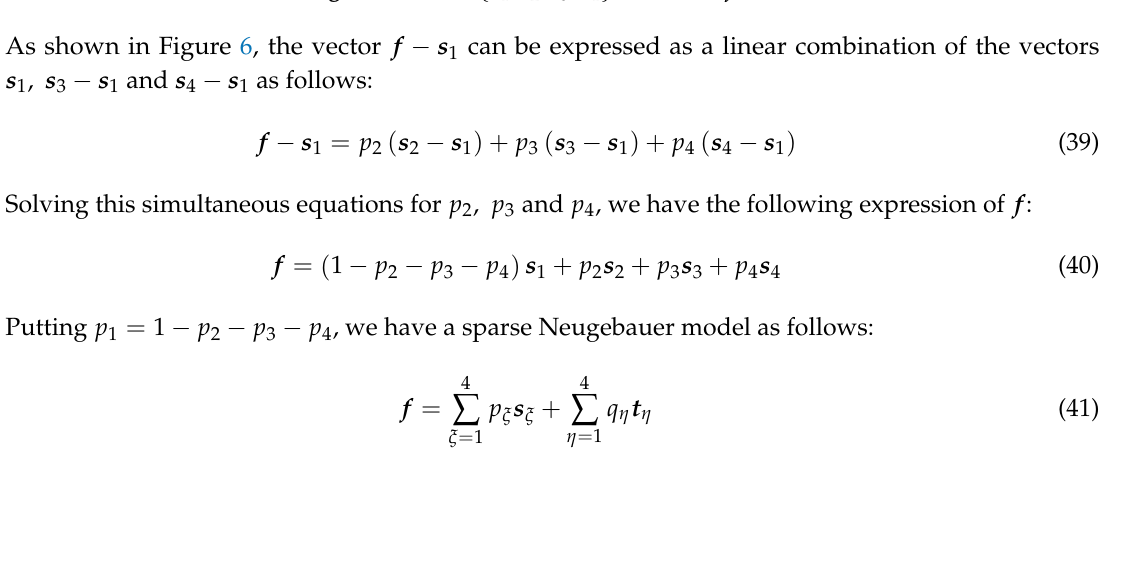
Figure 6. MBVQ { s 1 , s 2 , s 3 , s 4 } for a color f